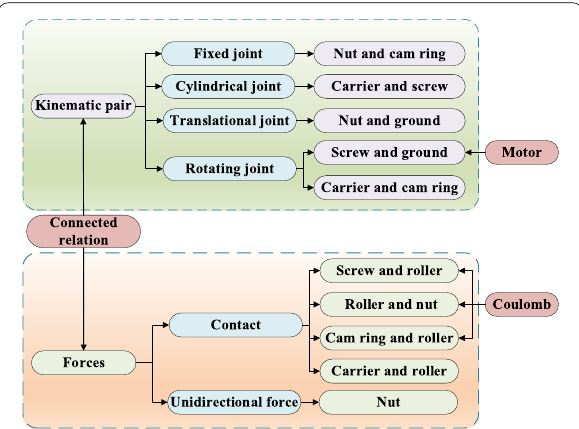
Figure 19 Roller assembly diagram Figure 20 Basic connection relation of virtual